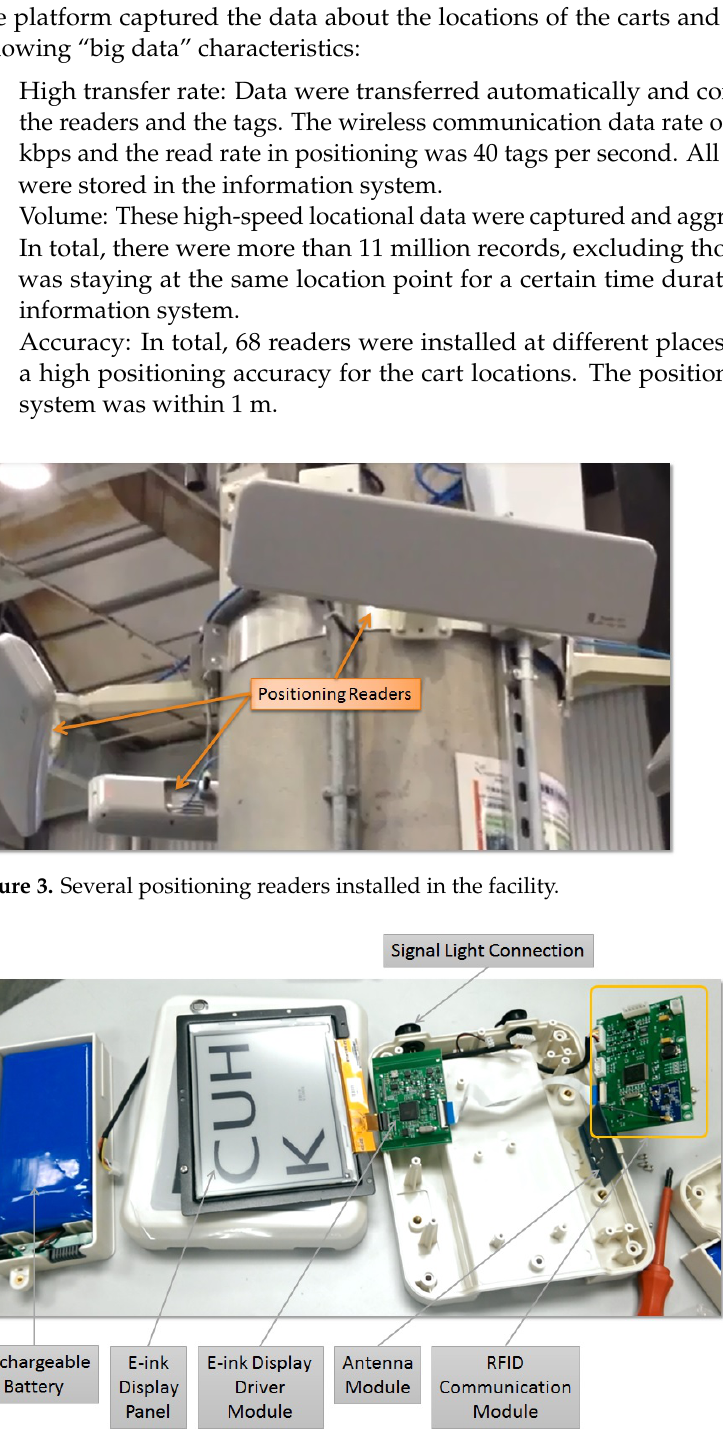
Figure 4. The display board (with the components of an RFID communication module and antenna module) installed on each of the